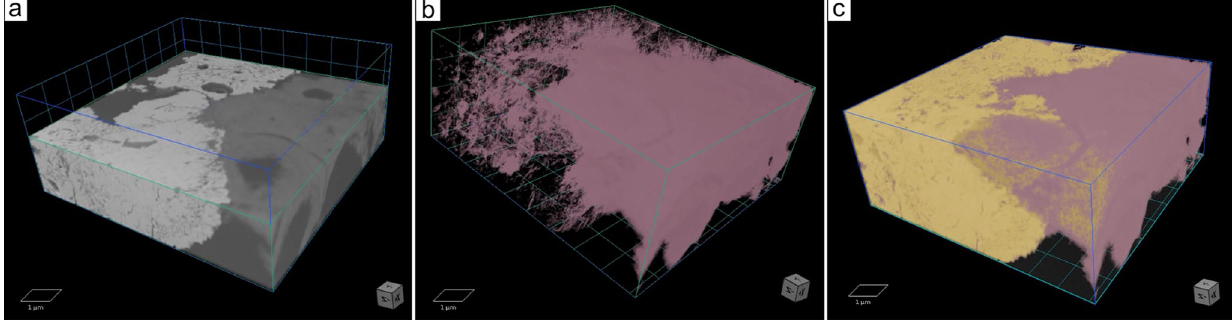
Fig. 6 FIB-SEM nanotomography reconstruction from P31b. 3D reconstruction of part of the ROI from P31b, showing the Mg-clay and Ca – Mn carbonate association: a Ca – Mn carbonate (light gray) in juxtaposition with the Mg-clay (mid gray), b Mg – clay spatial con fi guration after removing the carbonate from model, c Mg-clay (pink) and Ca – Mn carbonate (yellow) intimately intermingled – block rotated approximately 180 degrees around the vertical axis. 3D video reconstruction is available as Supplementary Video